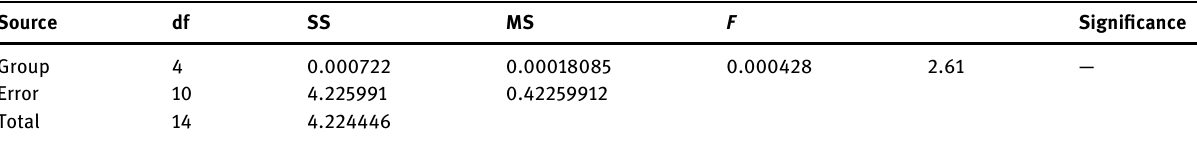
Table 3: Variance analysis of HBSA yields at various temperatures